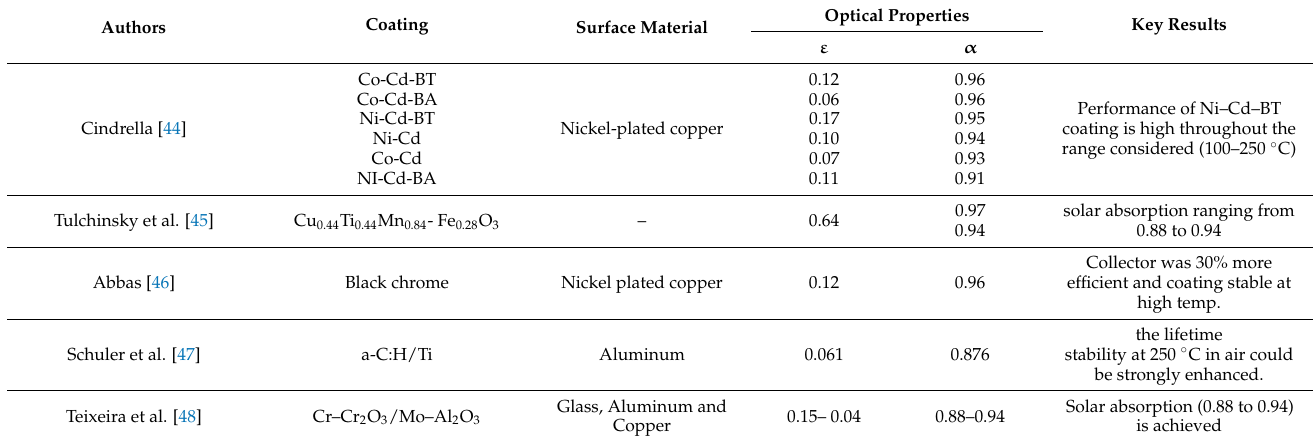
Table 3. Selective studies on